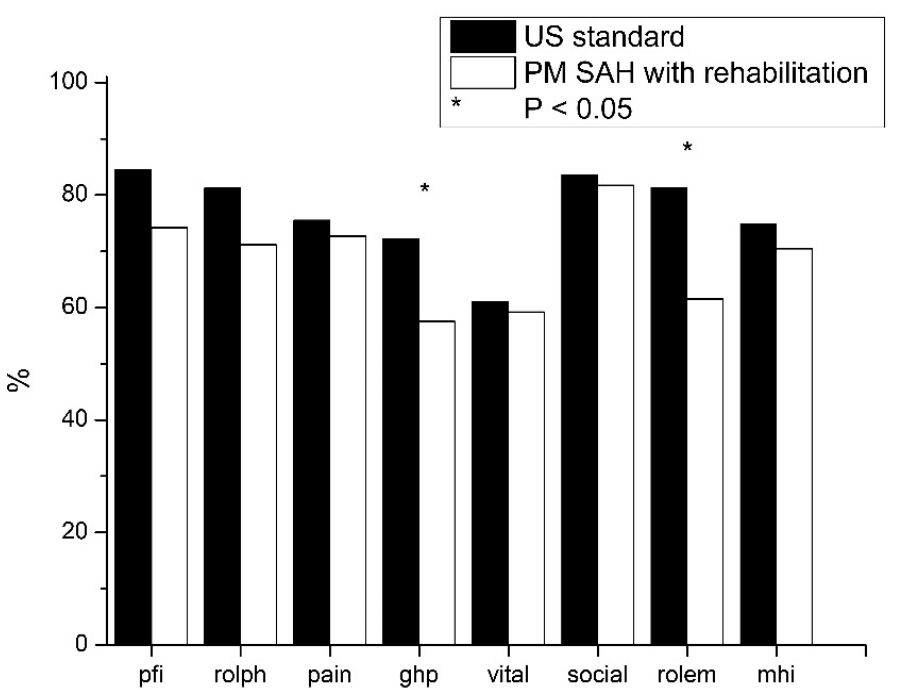
Figure 3. Outcome of patients with PM SAH and subsequent rehabilitation compared to standard population. In patients with PM SAH and rehabilitation ( white ) group, only ghp and rolem are significantly reduced compared to the standard population ( black ).